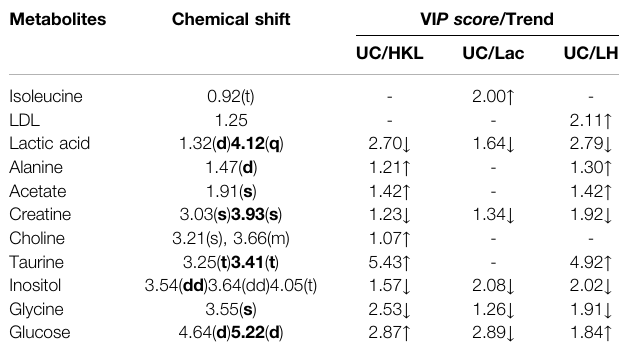
TABLE1 | Differentially expressed metabolites in the normal and UC groups. Metabolites